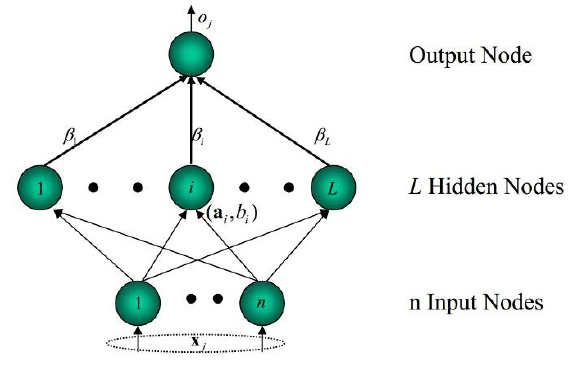
Figure 2. The structure of the extreme learning machine (ELM).